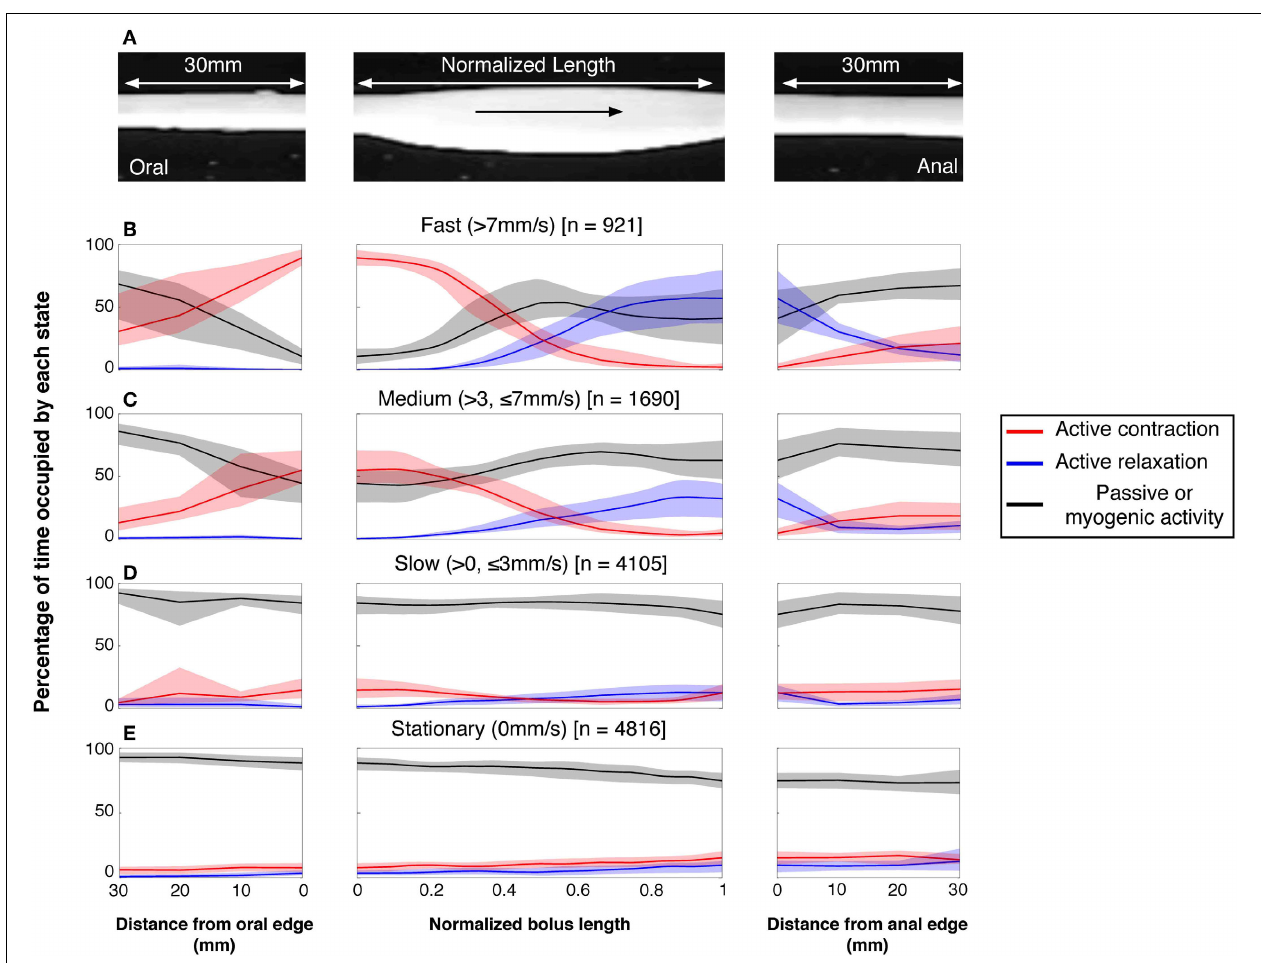
FIGURE 11 | The neurogenic active states associated with all moving and stationary boluses in the rabbit distal colon. (A) The active states were calculated on a frame by frame basis in a 30mm section of gut before and after the bolus and throughout the actual location of the bolus. In (B–E) , the red lines indicate the percentage time occupied by active contractions at each frame of analysis. The blue lines indicate the active relaxation and the black lines represent all other muscular states (passive and myogenic). The color-coded shading around each line represents the 95% confidence interval for the mean percentages over each rabbit. The speed of propagation has been divided into 3 bins (B) > 7mm/s; (C) > 3 ≤ 7mm/s; (D) > 0 ≤ 3mm/s